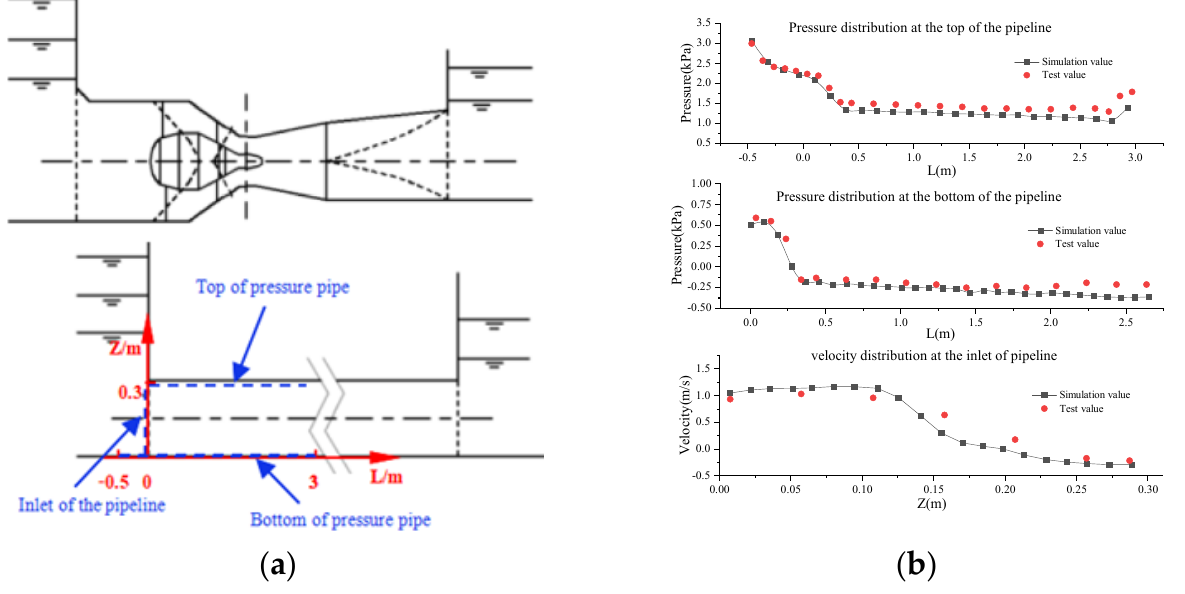
Figure 4. Model test verification: ( a ) Simplified model and measuring point layout; ( b ) comparison between numerical simulation and experiment.